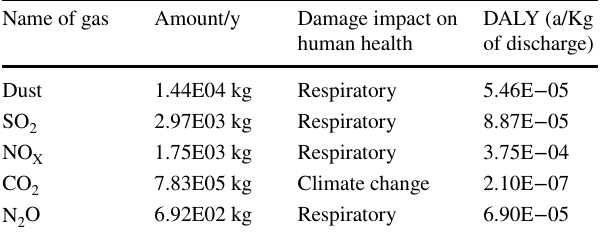
Table 3 DALY data of exhaust gas emission emissions in this article (Yan et al.